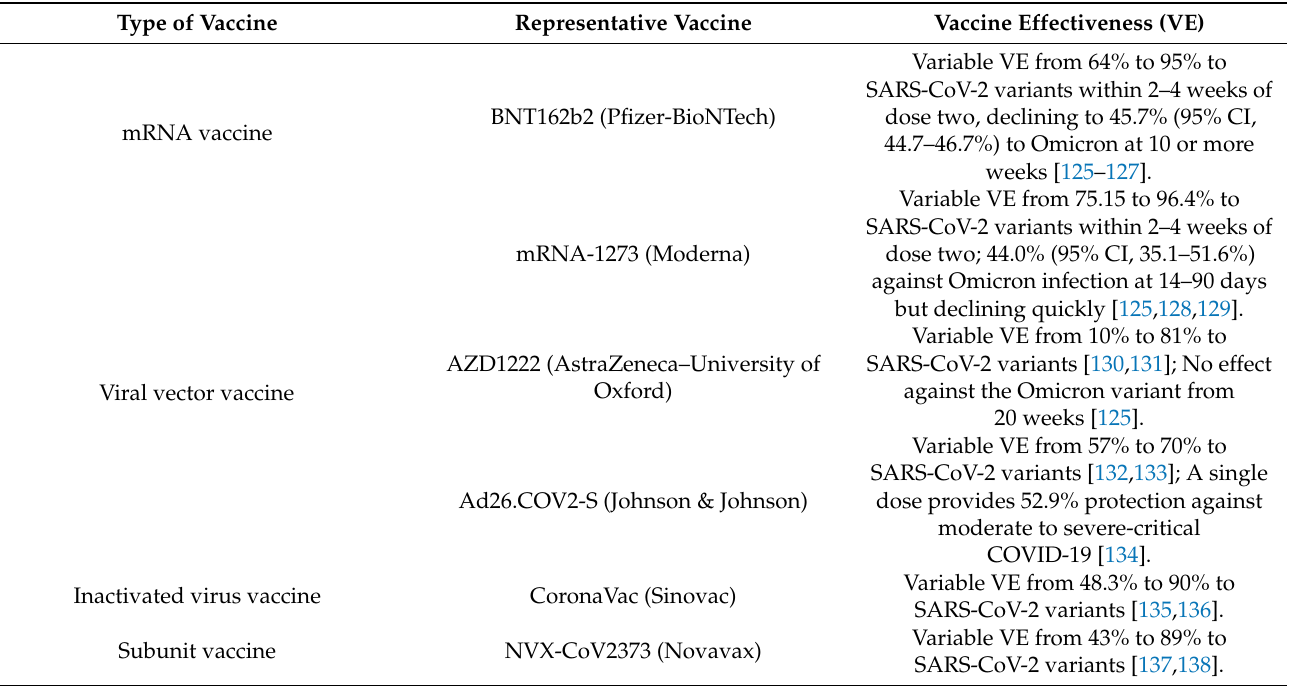
Table 4. Characteristics of different COVID-19